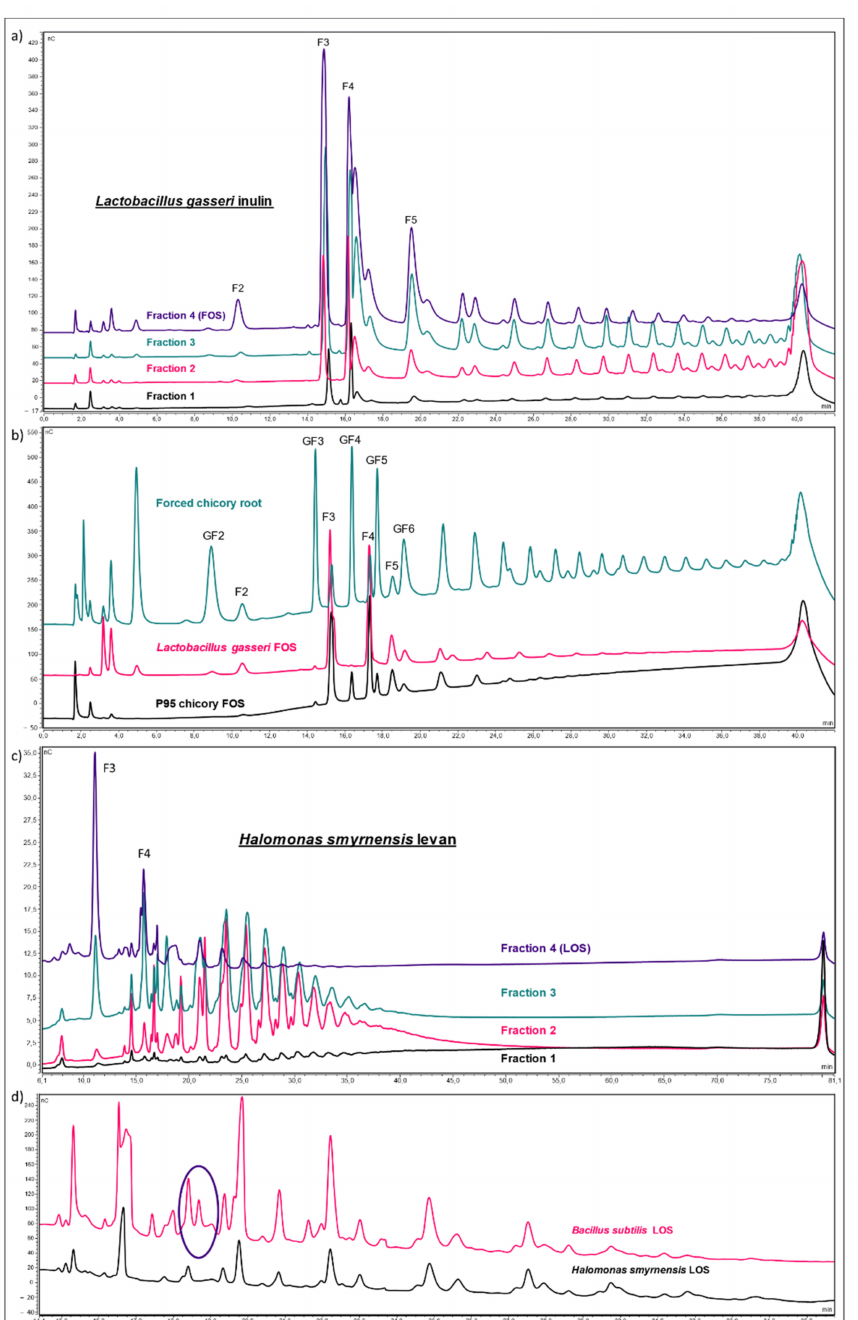
Figure 2. Different types of fructans used as priming agent and the production of fructan hydrolysis products. ( a ) Lactobacillus gasseri was hydrolyzed by Aspergillus niger endo-inulinase. Products were separated by degree of polymerization (DP) using acetone precipitation. ( b ) Fructooligosaccharide (FOS) profile of L. gasseri was compared to P95 chicory FOS and peaks identified with a forced chicory root reference sample. ( c ) A Bacteroides thetatiotaomicron endo-levanase was used to hydrolyze Halomonas smyrnensis levan into different DP fractions, fraction 4 resembling levan oligosaccharides (LOS). ( d ) Comparison between H. smyrnensis and Bacillus subtilis LOS fraction indicates a different degree of branching, exemplified in the purple circle. Samples were analyzed on HPAEC-IPAD. GFn peaks indicate inulin or levan of DP n + 1. Fn peaks indicate fructose-only type of fructans of DP n. X-axis indicates retention time (min), while y-axis shows the amperometric signal